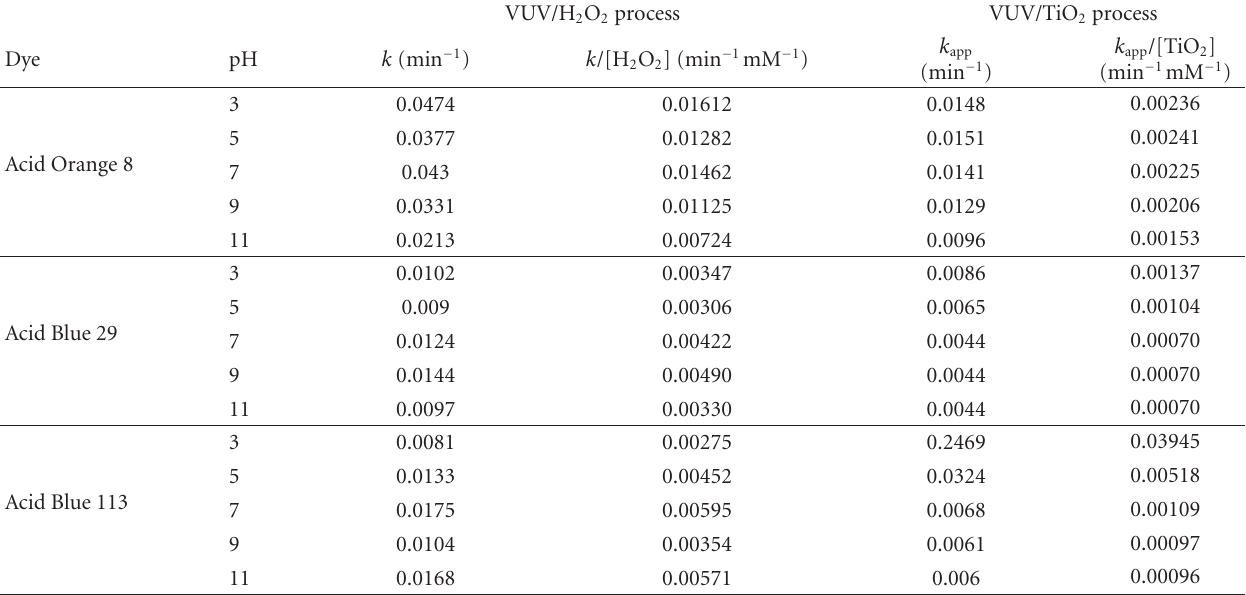
Table 5: The comparison of oxidation e ffi